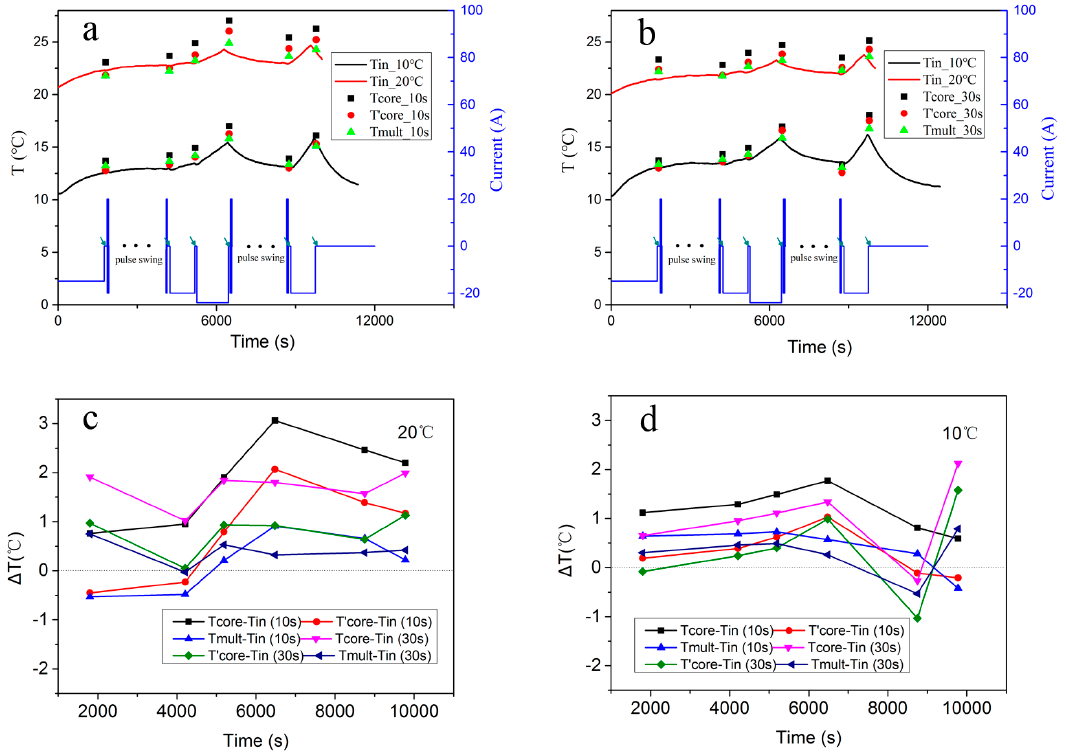
Figure 9. Estimated results with 10 s and 30 s relaxation time. Estimated results with ( a ) 10 s; ( b ) 30 s relaxation time; and temperature error at ( c ) 20 °C; ( d ) 10 °C.